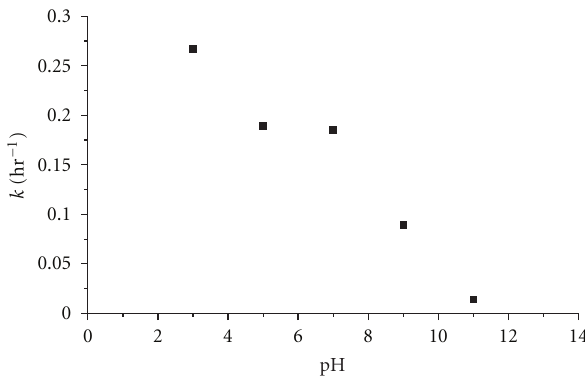
Figure 4: Relationship of the rate constant under di ff erent pH.